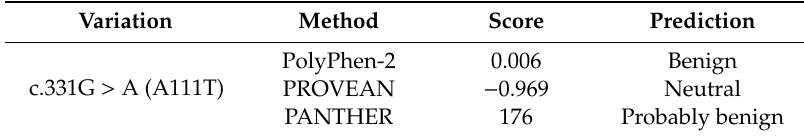
Table 4. Prediction of the deleterious e ff ect of the nonsynonymous polymorphism in the horse PRND gene by PolyPhen-2, PROVEAN, and PANTHER.